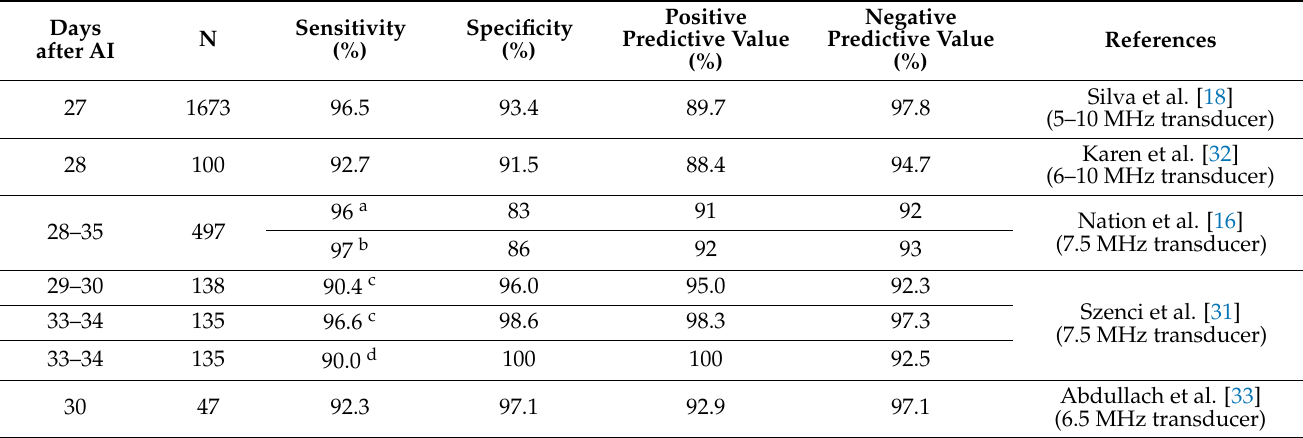
Table 3. Accuracy of ultrasonographic examinations for diagnosing early pregnancy in dairy cattle by using a high frequency linear-array